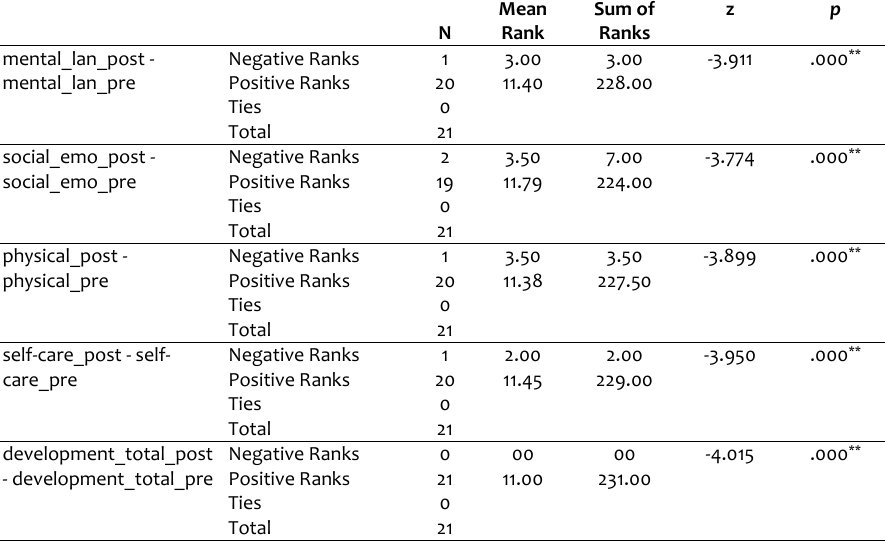
Table 4. Pre-test and post test results of the development scores in experimental group